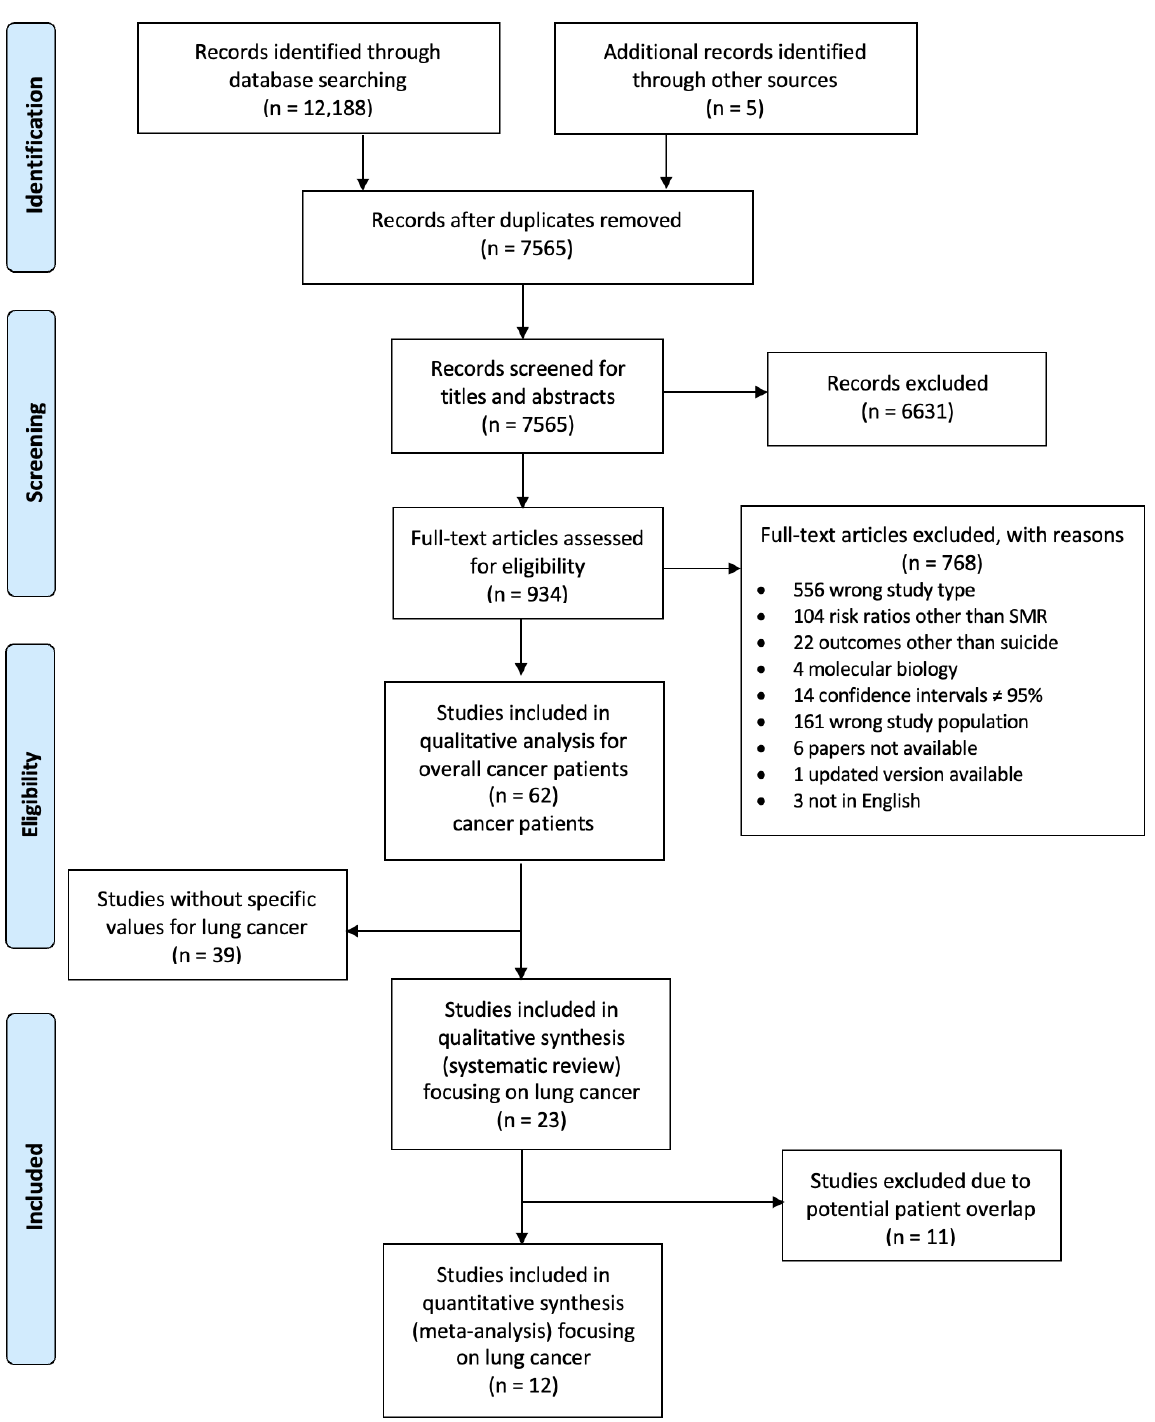
Figure 1. PRISMA Flow Diagram for study selection. Abbreviations: n , number of